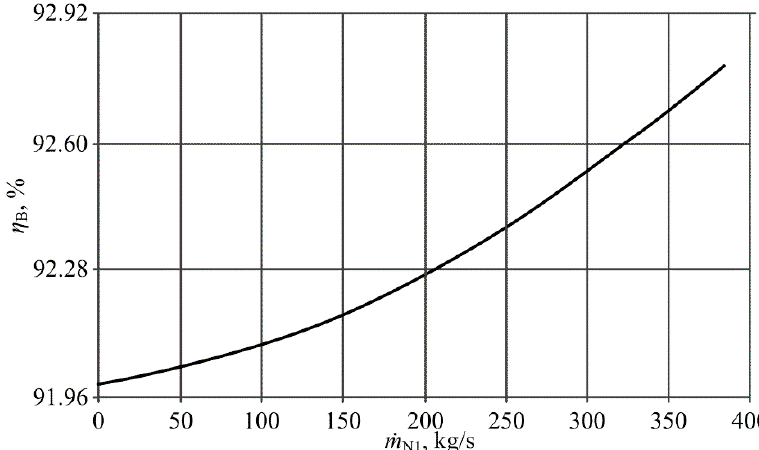
Figure 17. Thermal efficiency of the fluidized-bed boiler as a function of the drying medium’s flow rate in a lignite dryer (Variant V1 of oxy-type power plant).